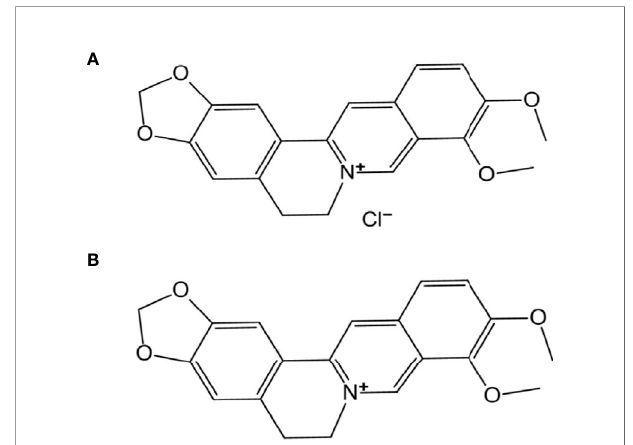
FIGURE 1 | Chemical structure of (A) berberine hydrochloride and (B)